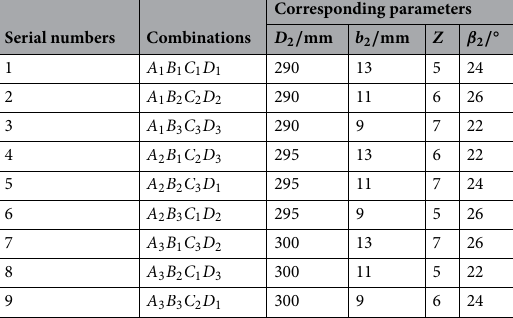
Table 2. Orthogonal test